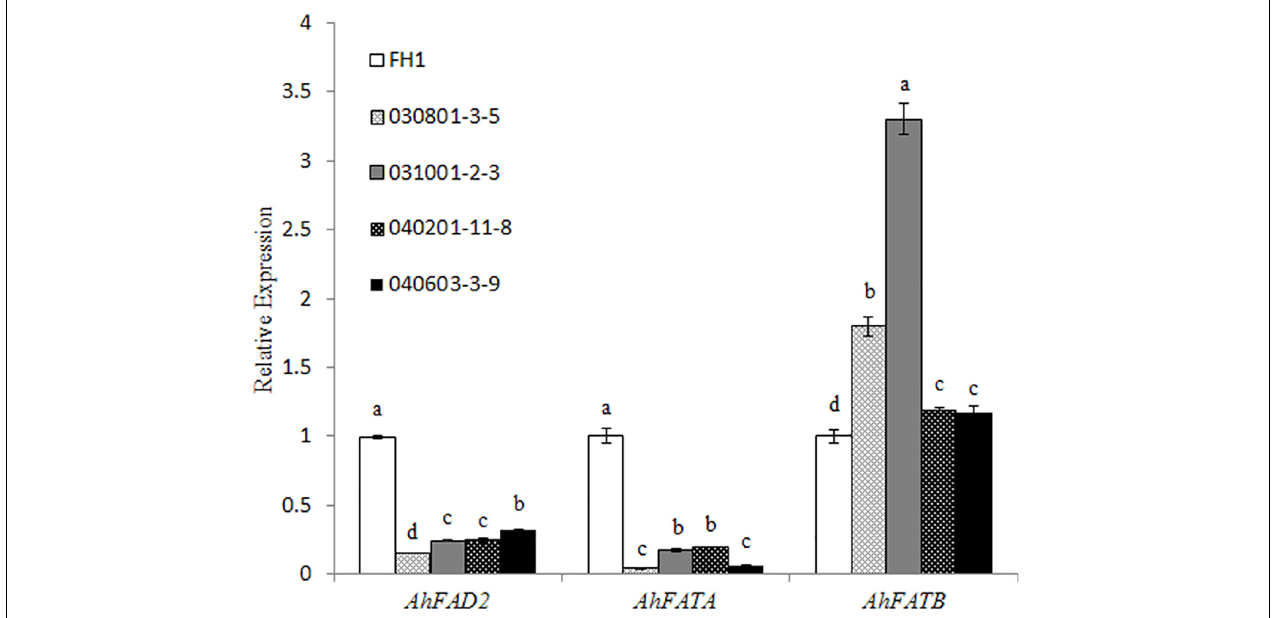
FIGURE 6 | Expression analysis of AhFAD2 , AhFATA , and AhFATB in the seeds of different transgenic lines at 30 DAP by qRT-PCR. One-way analysis of variance (ANOVA) for gene expression levels among different transgenic peanut lines and their control was performed by SPSS software, and the significance of differences ( p < 0.05) was assessed by Duncan’s new multiple range test with values with different letters being significantly different FH1, untransformed control. Relative transcript levels were quantified by comparison to that of peanut actin7 as a reference